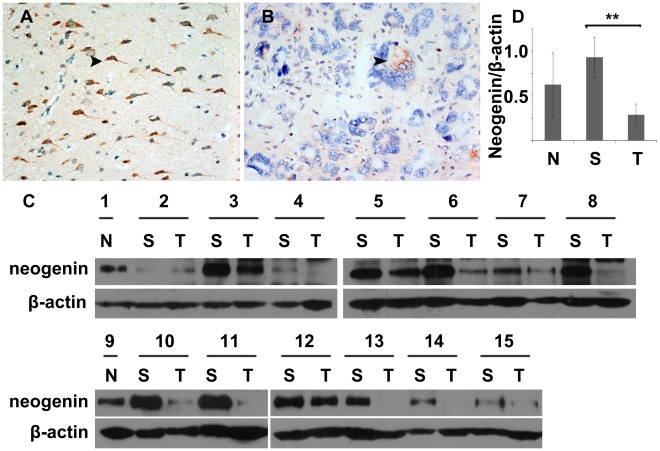
The difference of neogenin expression between gliomas and their homologous surrounding tissues.(A–B) Representative immunohistochemical pictures (200× magnification): (A) The surrounding tissue of the tumor, the arrow points to a positive normal cell; (B) The typical glioblastoma area, the arrow points to positive tumor cell. (C) Western blot showed neogenin expression in normal brains (N), surrounding non-neoplastic tissues (S) and homologous gliomas (T). (D) Statistical graph of neogenin expression in surrounding non-neoplastic tissues and gliomas. Paired t -test, n = 13, ** p<0.01, error bars indicate standard error means.